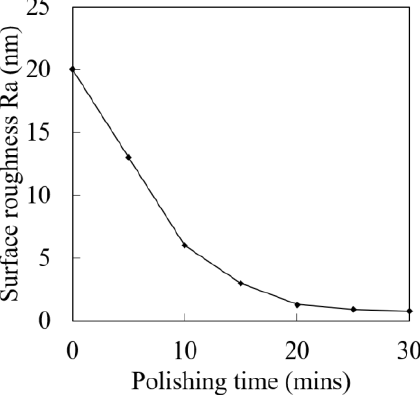
Figure 6. Variation in surface roughness R a with polishing time.